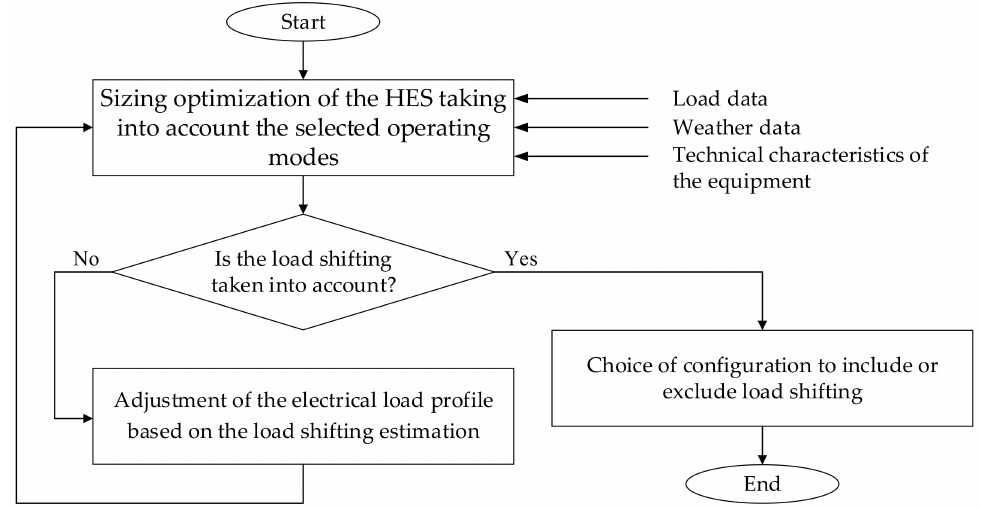
Figure 1. Algorithm for multi-purpose optimization of the size of autonomous HESs with RESs and load shifting